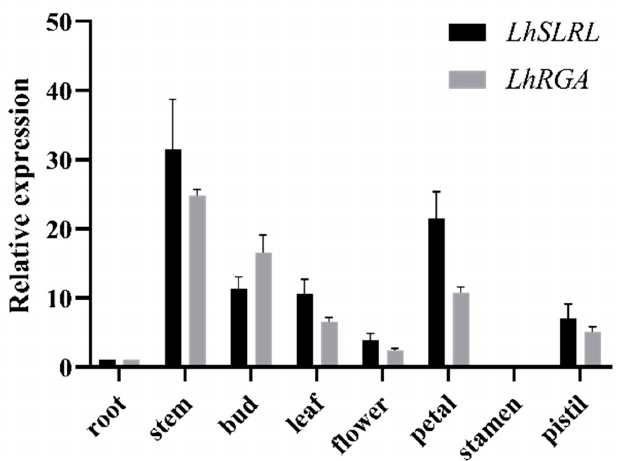
Figure 4. Expression profile of LhDELLA s in Liriodendron hybrids. Quantitative real time PCR analysis of LhDELLA s in the following organs / tissues from Liriodendron hybrids: root, stem, bud, leaf, flower, petal, stamen, and pistil. The Liriodendron hybrids 18S gene was used as a reference gene. Error bars represent ± SD from three biological repeats.